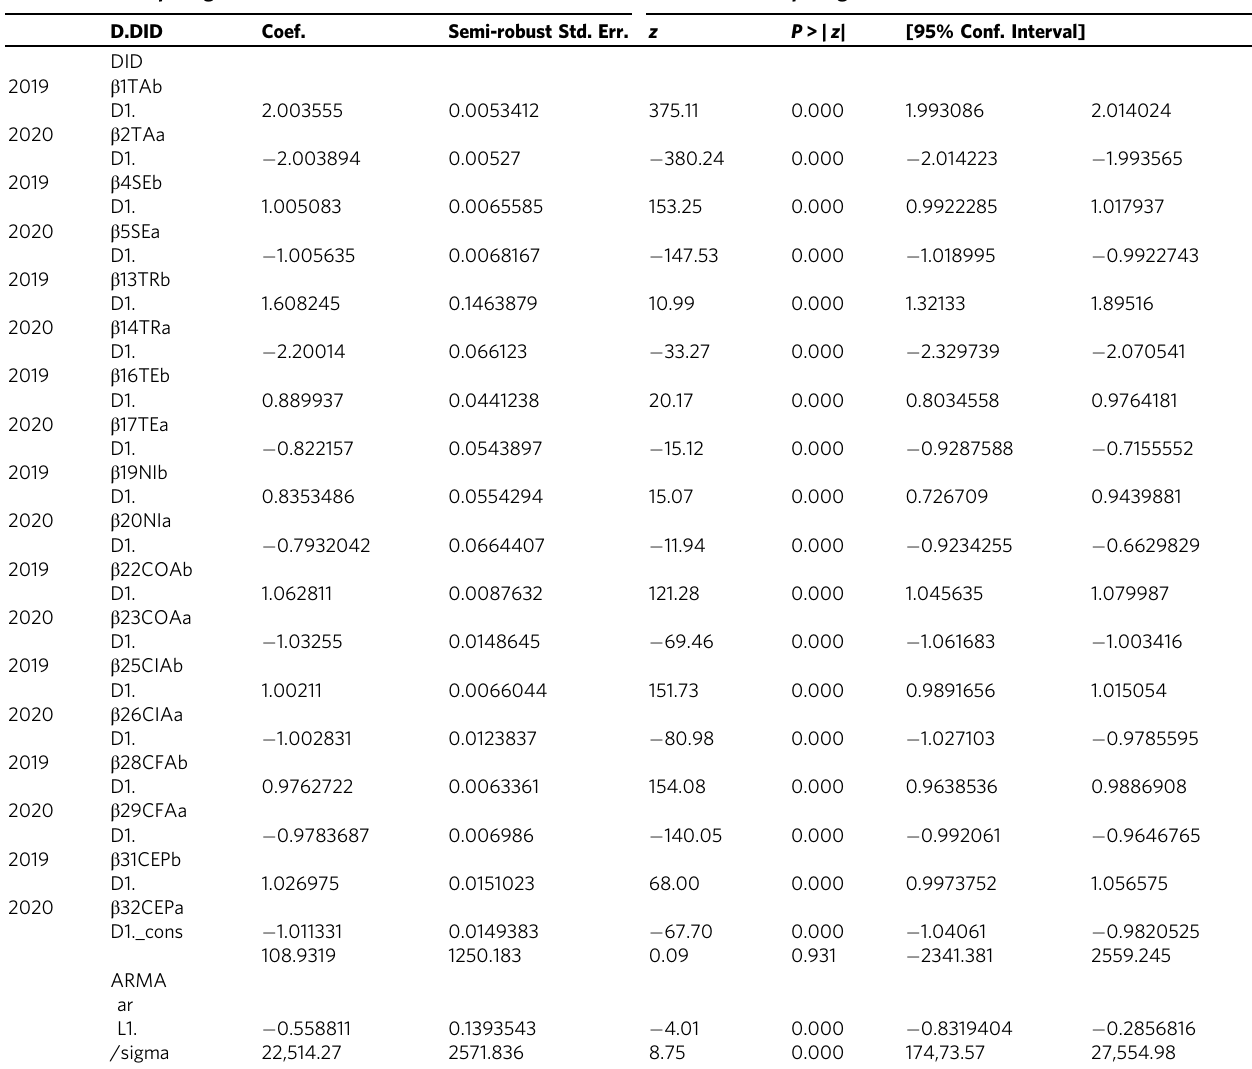
Table 8 ARIMA (1,1,0) regression.